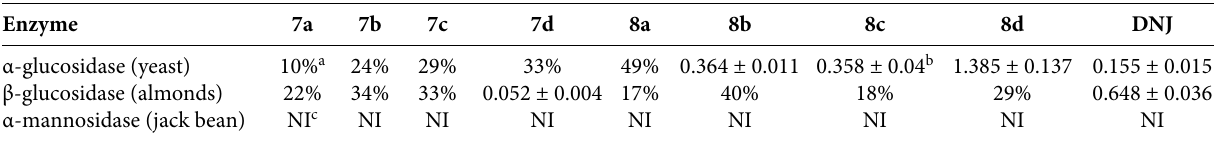
Table 1. Glycosidase inhibitory activity values IC 50 (mM) Enzyme 7a α-glucosidase (yeast) β-glucosidase